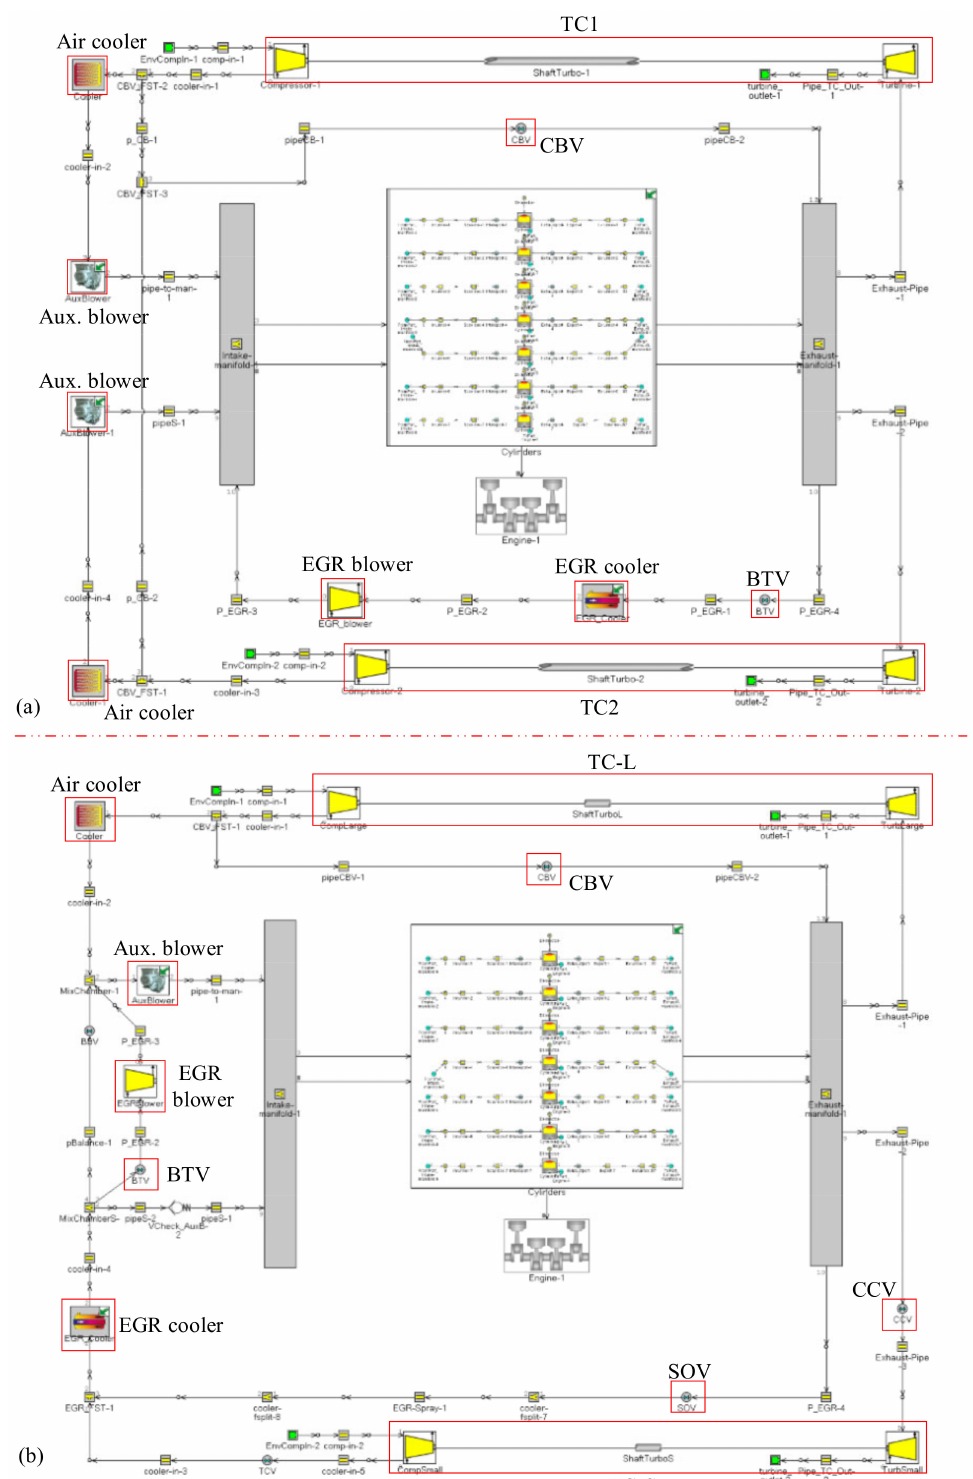
Figure 2. Flowcharts of GT-SUITE models for: ( a ) the baseline (BL-EGR) engine configuration; and ( b ) the alternative (AL-EGR) engine